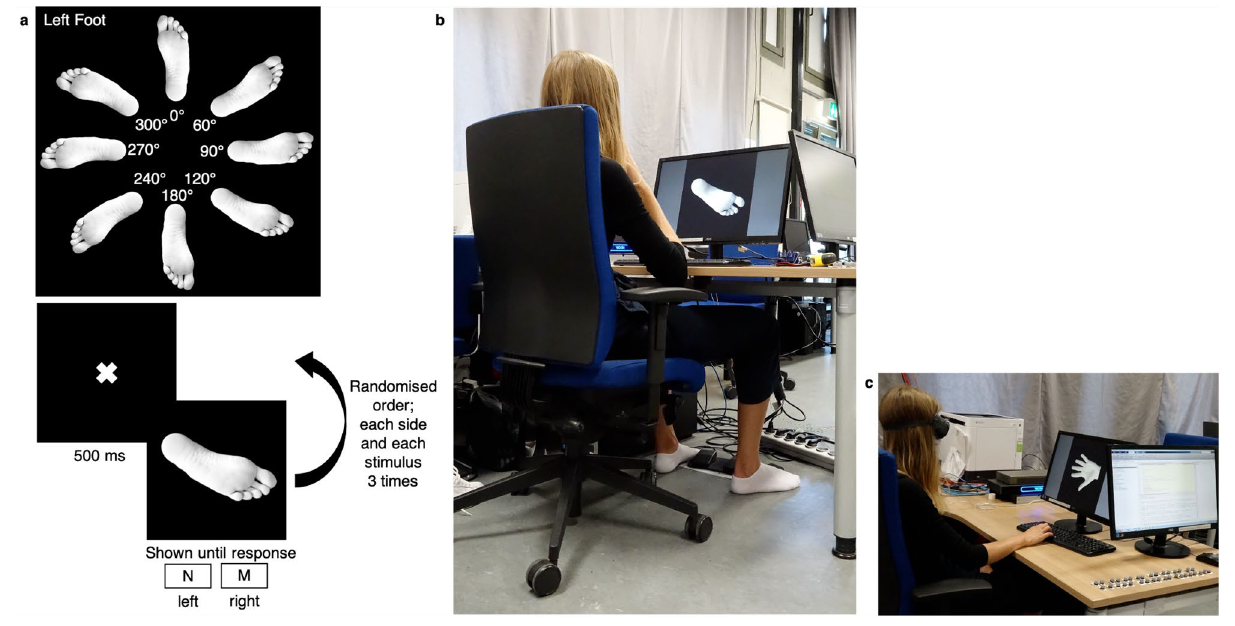
Figure 6. Laterality task; ( a ) top: 8 orientations/stimuli presented, examplary for FLAT ; a bottom: task procedure, N and M represent the keyboard keys to press for HLAT , which corresponded to left and right pedal for FLAT ; ( b ) setup during FLAT ; ( c ) setup during HLAT